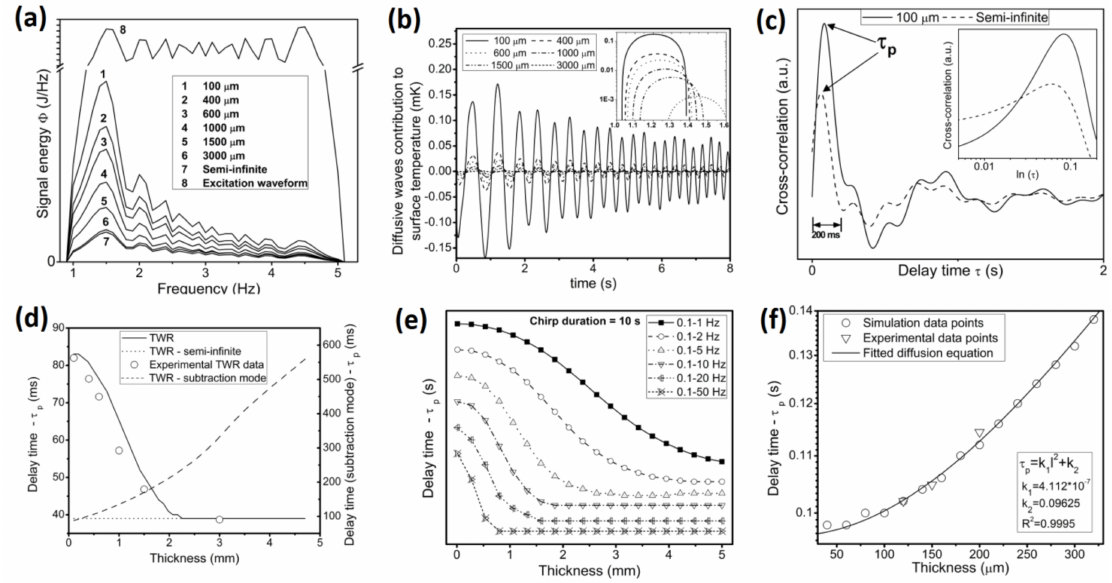
Figure 3. Simulated ( a ) spectral responses and ( b ) Thermal-wave radar (TWR) subtractive surface temperature evolution over blind holes of different thicknesses; ( c ) simulated TWR outputs for 100 µ m thick and semi-infinite steel samples; ( d ) variation of TWR peak delay time with opaque sample thickness in normal and subtraction modes; ( e ) effect of TWR excitation waveform parameters on detectability of defects; ( f ) variation of TWR peak delay time with absorber depth in turbid medium